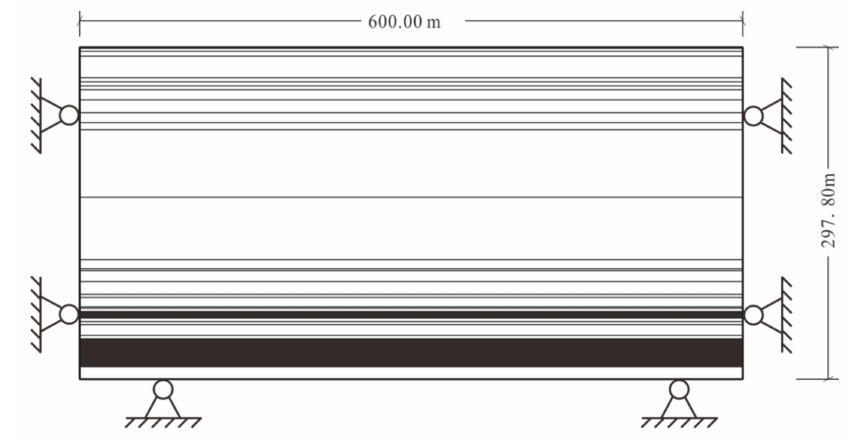
Figure 6. Schematic diagram of the numerical model [22].